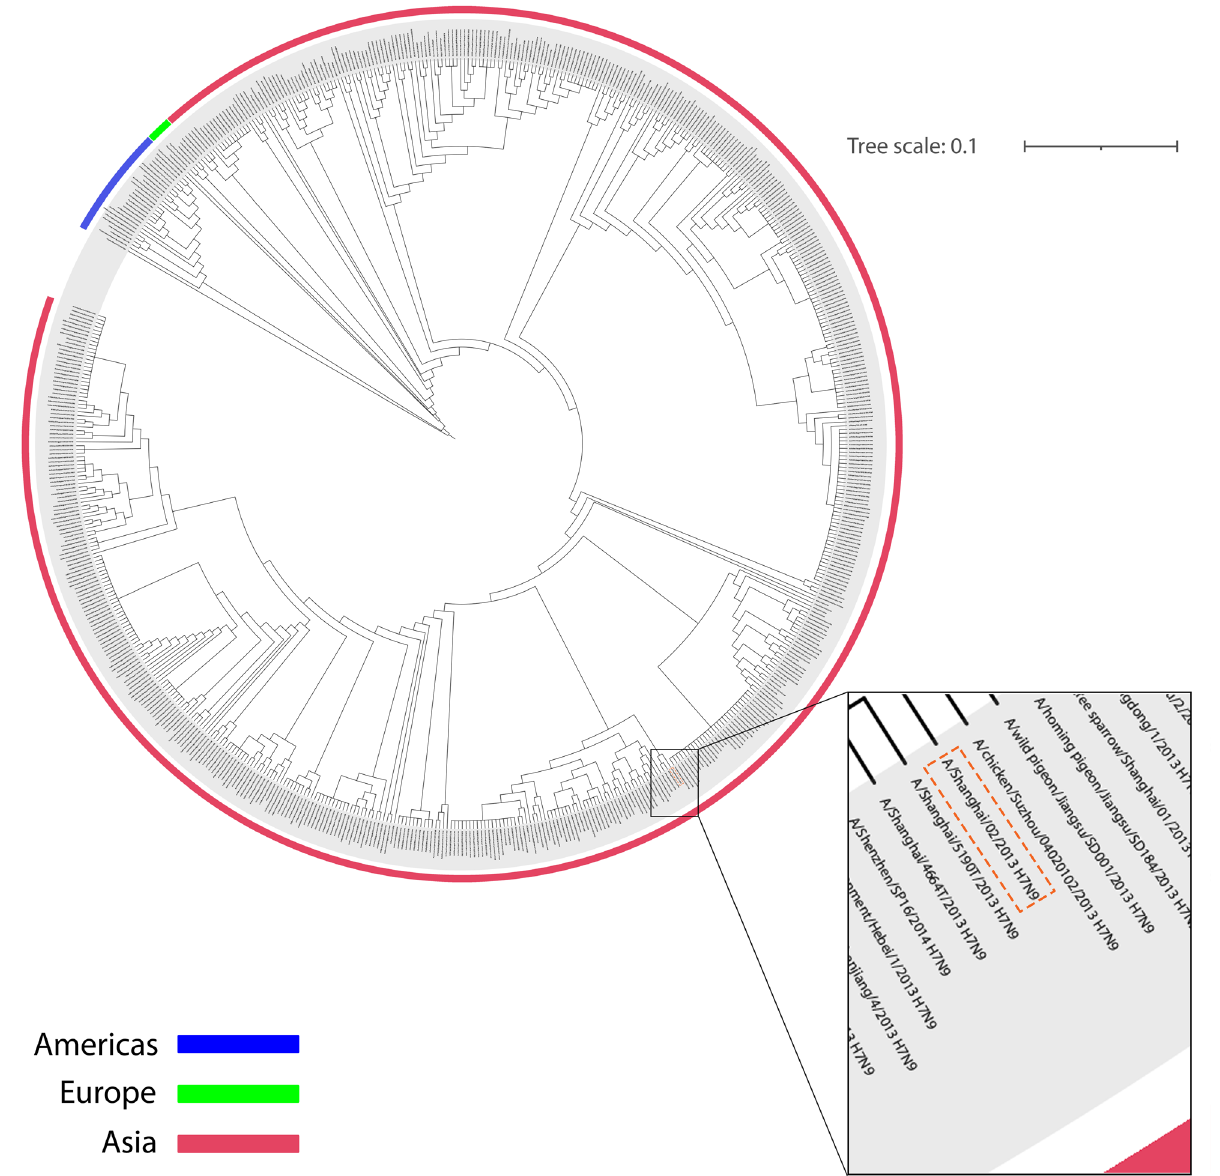
Figure 2. NA circular phylogenetic tree. The amino acid sequence of NA (A/Shanghai/2/2013 H7N9) was evaluated with other 620 (H7N9) NA amino acid-based on NCBI Influenza Virus Resource. The tree scale was considered equal to 0.1. All H7N9 NA proteins are related to human-derived, avian-derived and environment- derived. Spread H7N9 HA in the Americas, Europe and Asia are shown in blue, green and pink line, respectively. NA protein of A/Shanghai/2/2013 H7N9 has been magnified and specified in an orange dashed- line